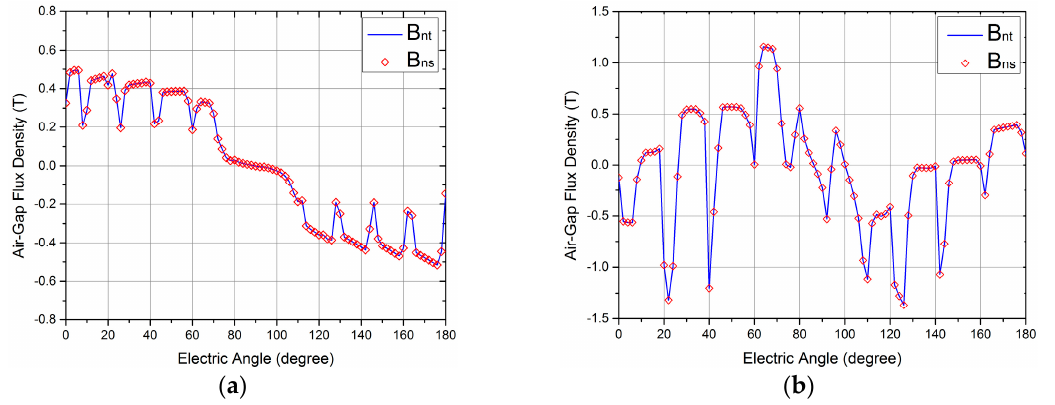
Figure 7. Air-gap flux density comparison. ( a ) No-load condition ( b ) at 0.01 s after short-circuit. B nt is the result of the field-circuit coupled time-stepping FE simulation in step 1, and B ns is the result of the static magnetic FE application in step 2.